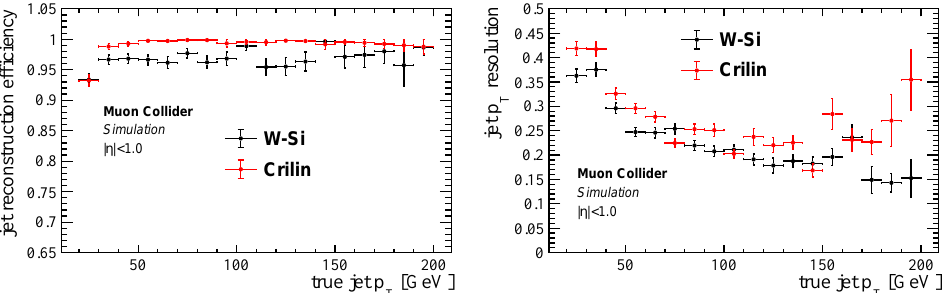
Figure 3. ( Left ): jet reconstruction efficiency as a function of the jet p T , obtained by using the Crilin ECAL barrel and the W-Si ECAL barrel. ( Right ): jet p T resolution as a function of the jet p T , obtained by using the Crilin ECAL barrel and the W-Si ECAL